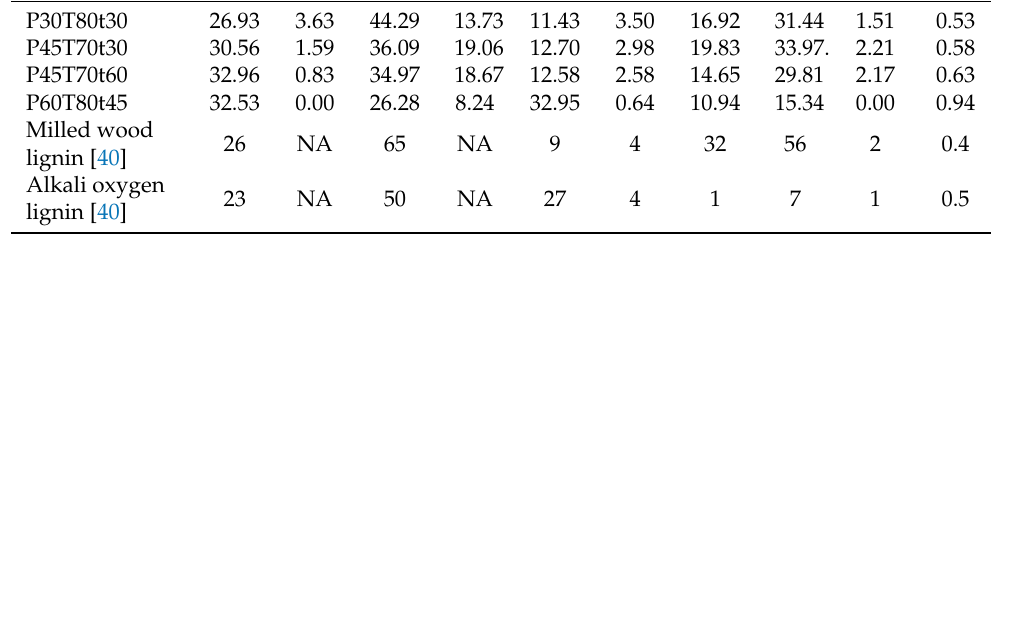
Table 4. Semi-quantitative analysis of lignin units and ratio, and linkages based on 2D-HSQC spectra.